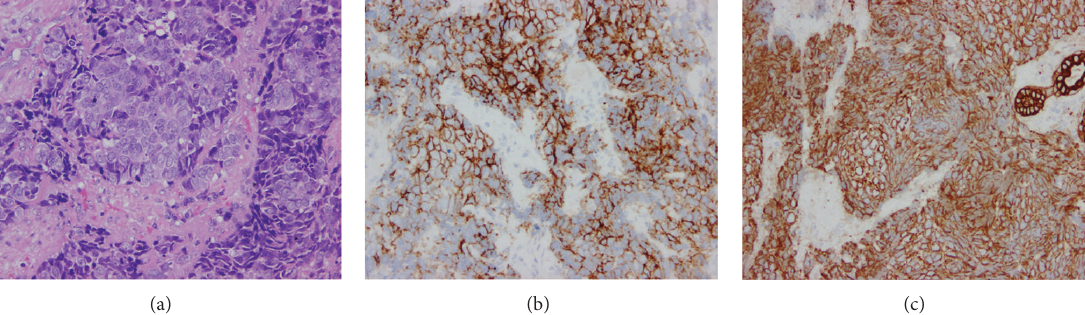
Figure 1: Representative histopathologic findings in the surgical specimen of the left lacrimal gland. H-E staining showed invasive prolifera- tion of atypical small cells with rosette formation (a). Immunostaining with CD56 (b) and CK (AE1/AE3) (c) was positive ( × 200).